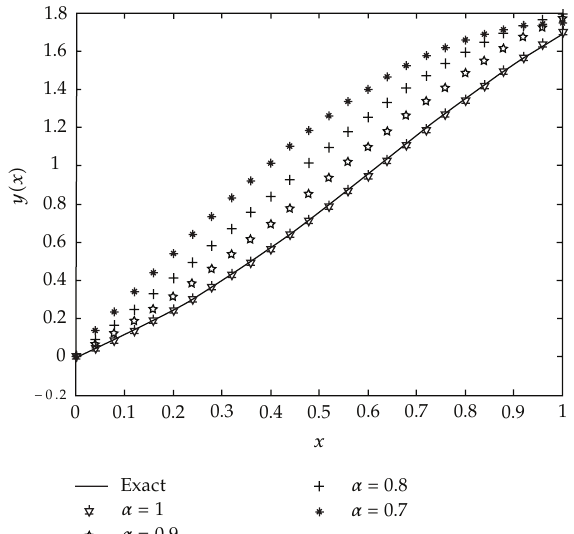
Figure 4: Plots of approx. solution y 3 (cid:3) x (cid:4) for di ff erent values of α